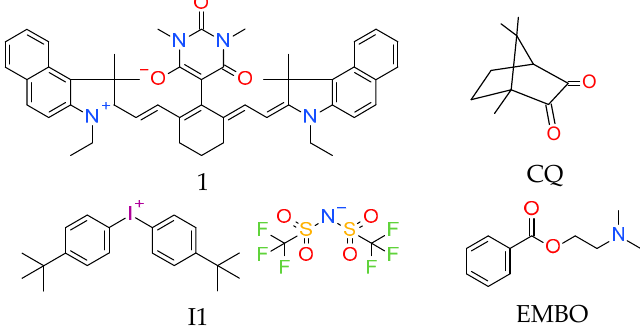
Figure 10. Structure of the photoinitiating system, based on CQ (0.3 (wt.%) / EMBO (0.5 wt.%) and (1) = 0.01 wt.%, (I1) = 4 wt.% or (1) = 0.02 wt.%, (I1) = 4 wt.%, which generates the brown color after photopolymerization.